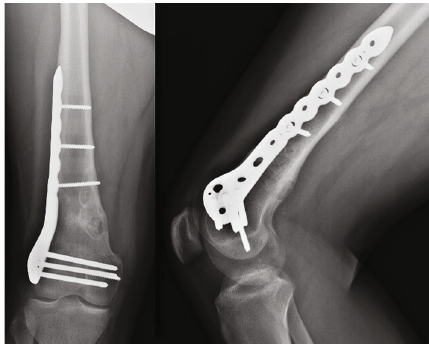
Figure 6: AP and lateral plain radiographs of the distal femur obtained at the fi nal clinic appointment, 6 weeks postoperatively, following diagnostic arthroscopy, curettage, and bone grafting with completely healed fracture.